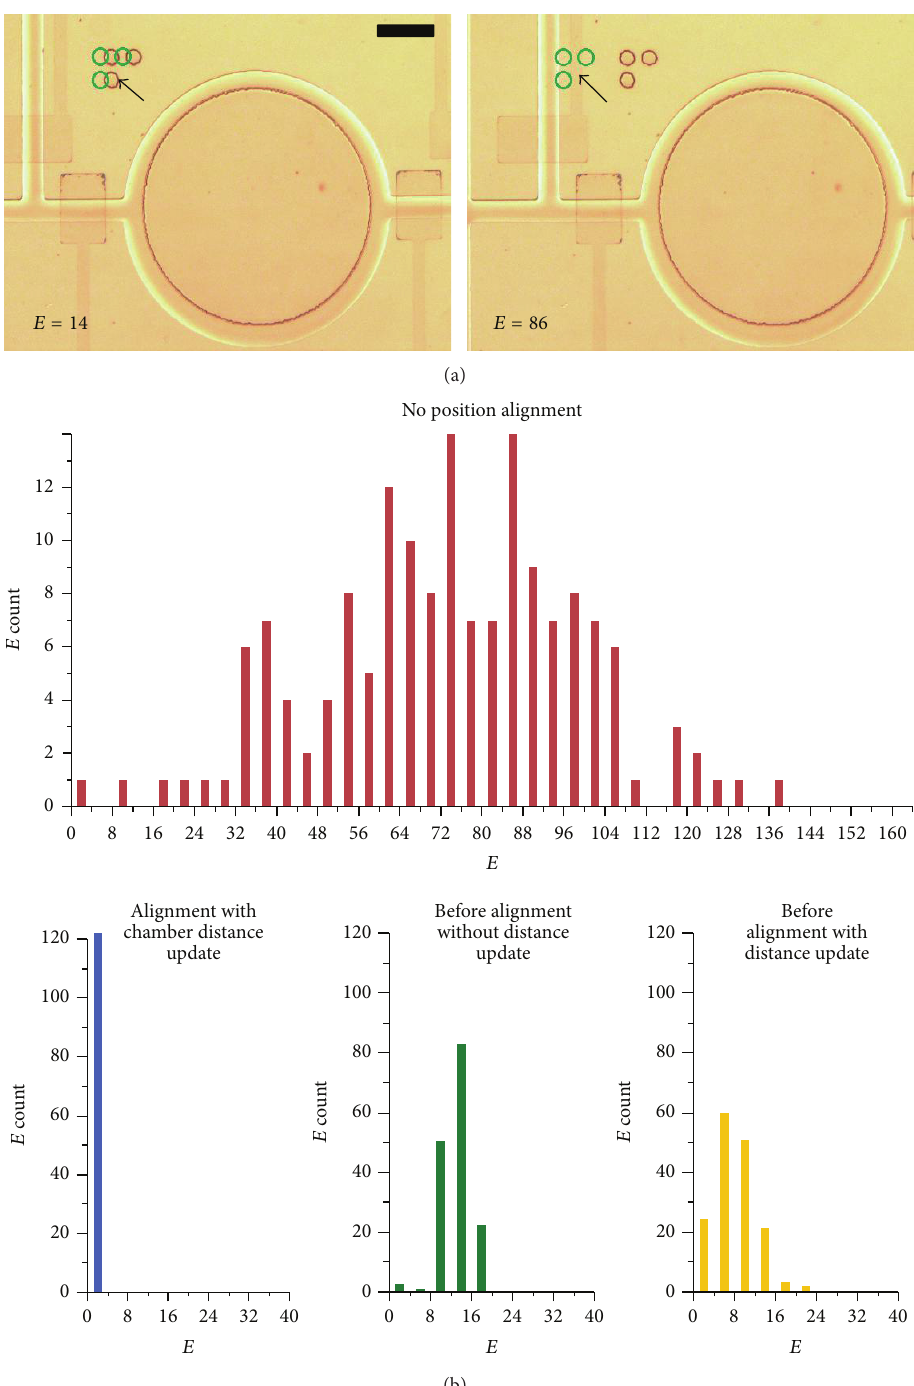
Figure 6: (a) Representative micrographs for two different position errors: E = 14 ( left ) and E = 86 ( right ). Arrows indicate the target positions of alignment marks. Scale bar: 250 𝜇 m. (b) Statistics of position errors for different cases throughout the automation chamber alignment